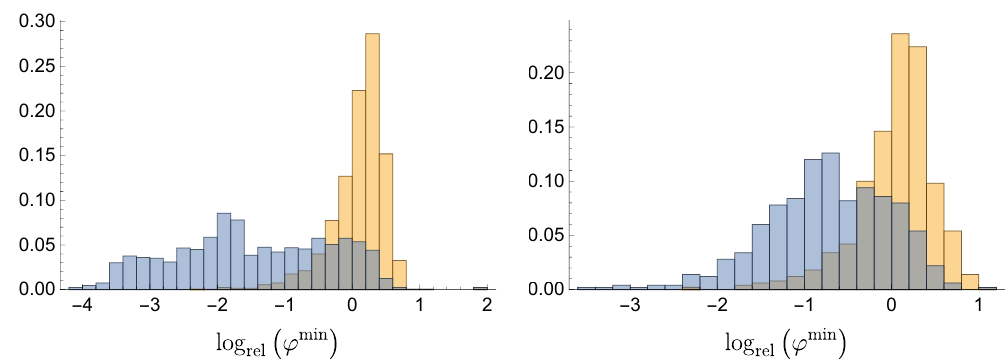
Figure 8 . Logarithmic relative error on ϕ min for 2-vev (left panel) and 3-vev (right panel) manifolds, using the minimisation procedure described in section 3.2 (yellow bars) and its improved version (blue bars), compared to a full-fledged numerical minimisation.